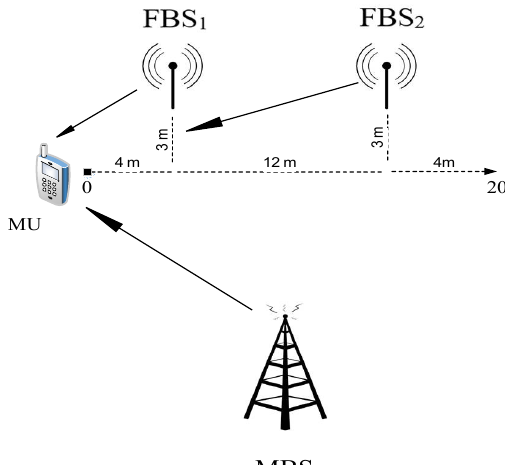
Figure 5. System description.